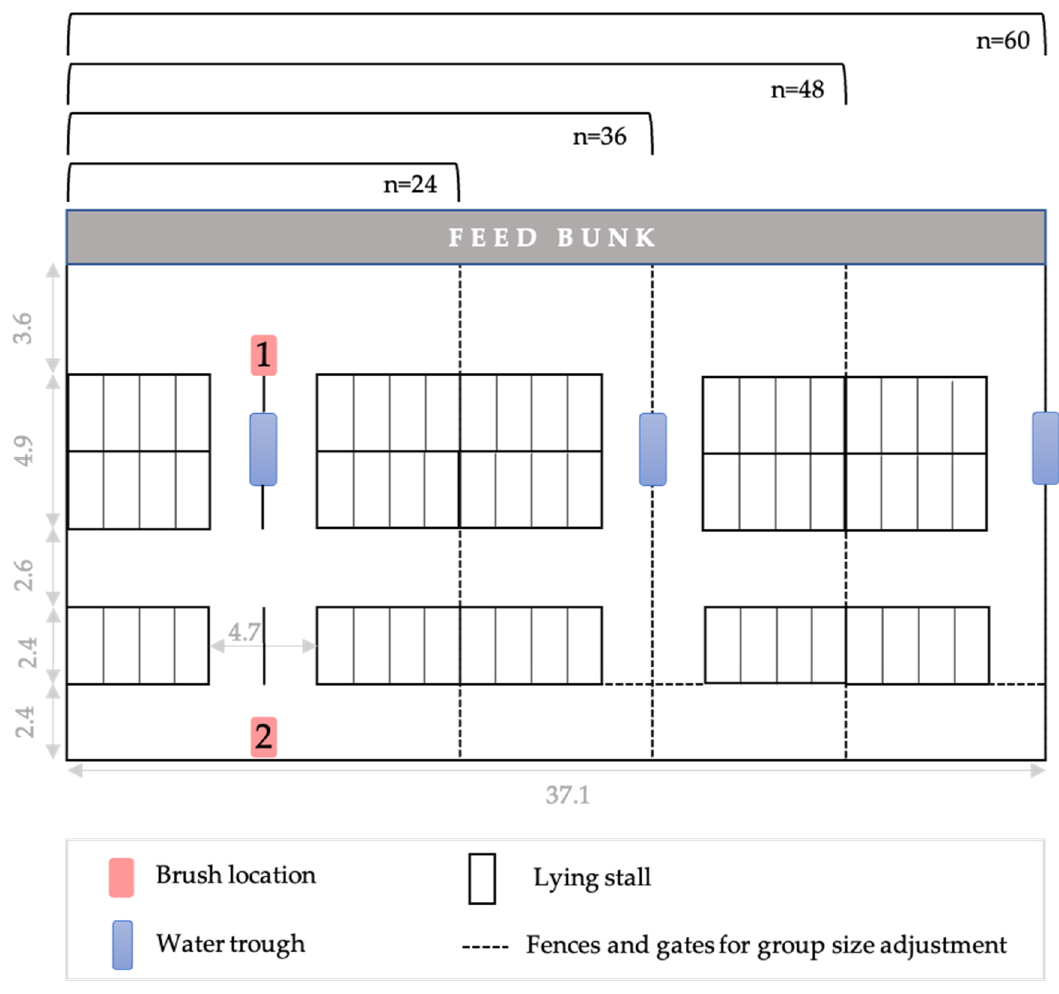
Figure 1. Pen layout for different group sizes (n = 24, 36, 48, 60) of lactating cows, showing the two locations (1: feed alley, 2: back alley) where the automated cylindrical-shaped brush was provided. Pen dimensions are shown in